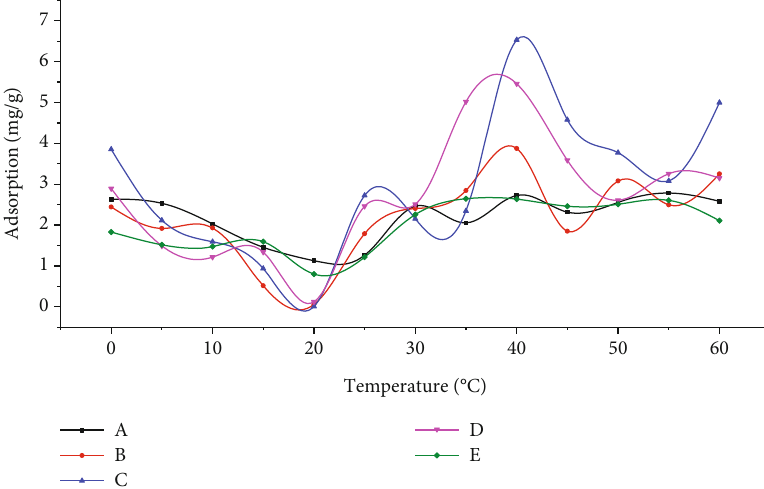
Figure 6: Adsorption quantity of MIPs in di ff erent molar ratios of 1: 1 (A), 1 :2 (B), 1 :3 (C), 1:4 (D), and 1 :5 (E) in di ff erent